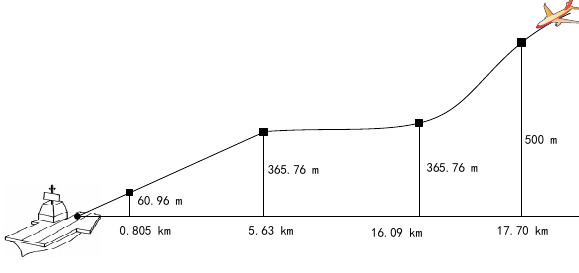
Figure 14. Simulation area of aircraft landing.